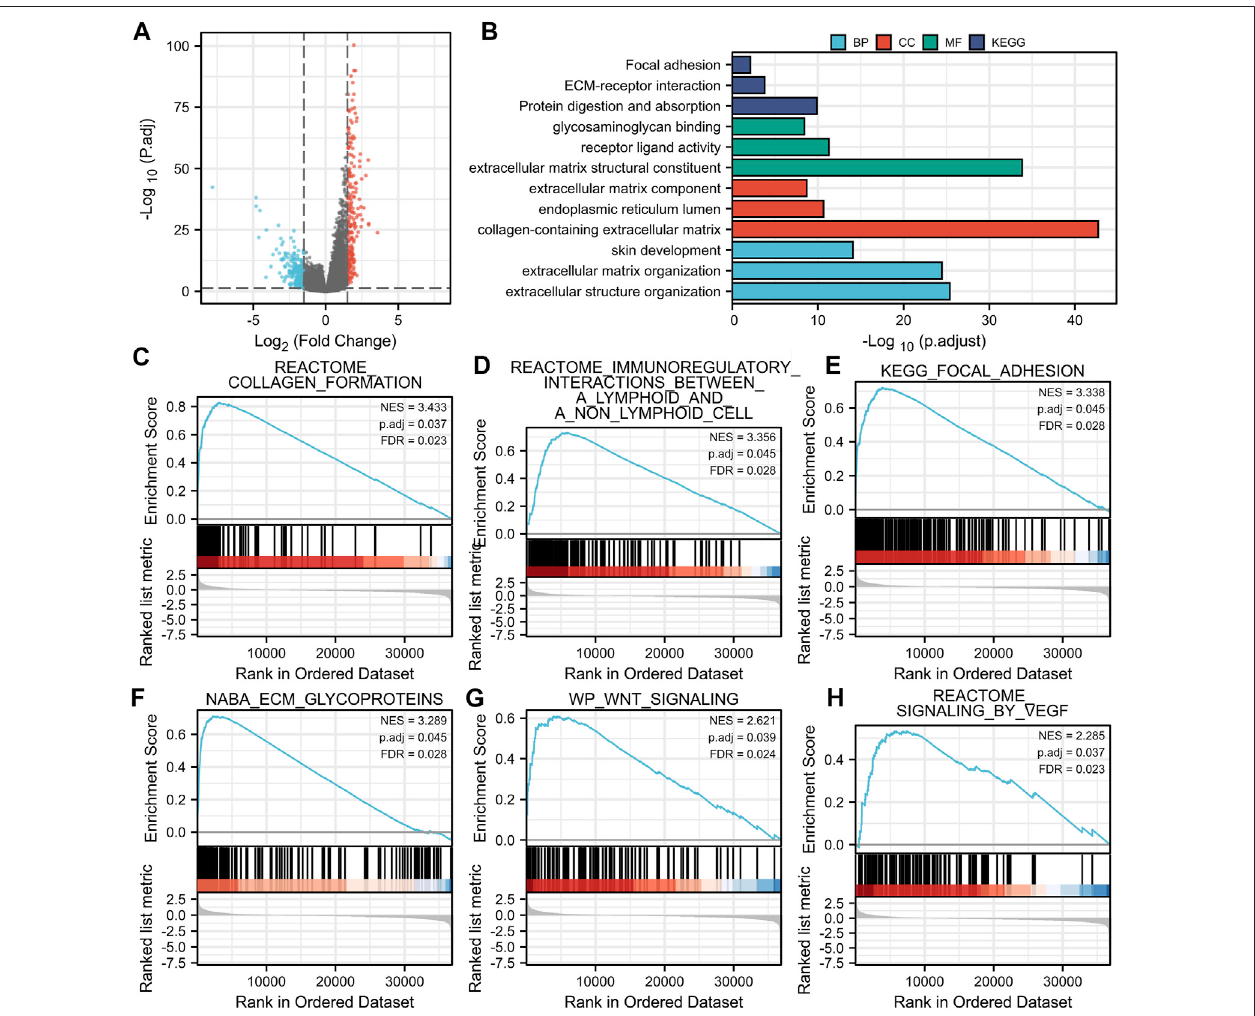
FIGURE7| Aquantitative methodtopredictGCpatients ’ probabilityof1-,3-,and5-yearsOS. (A) Anomogramforpredicting theprobabilityof1-,3-,and5-years OS for GC patients. (B) Calibration plots of the nomogram for predicting the probability of OS at 1, 3, and 5 years. GC, gastric cancer; OS, overall survival.